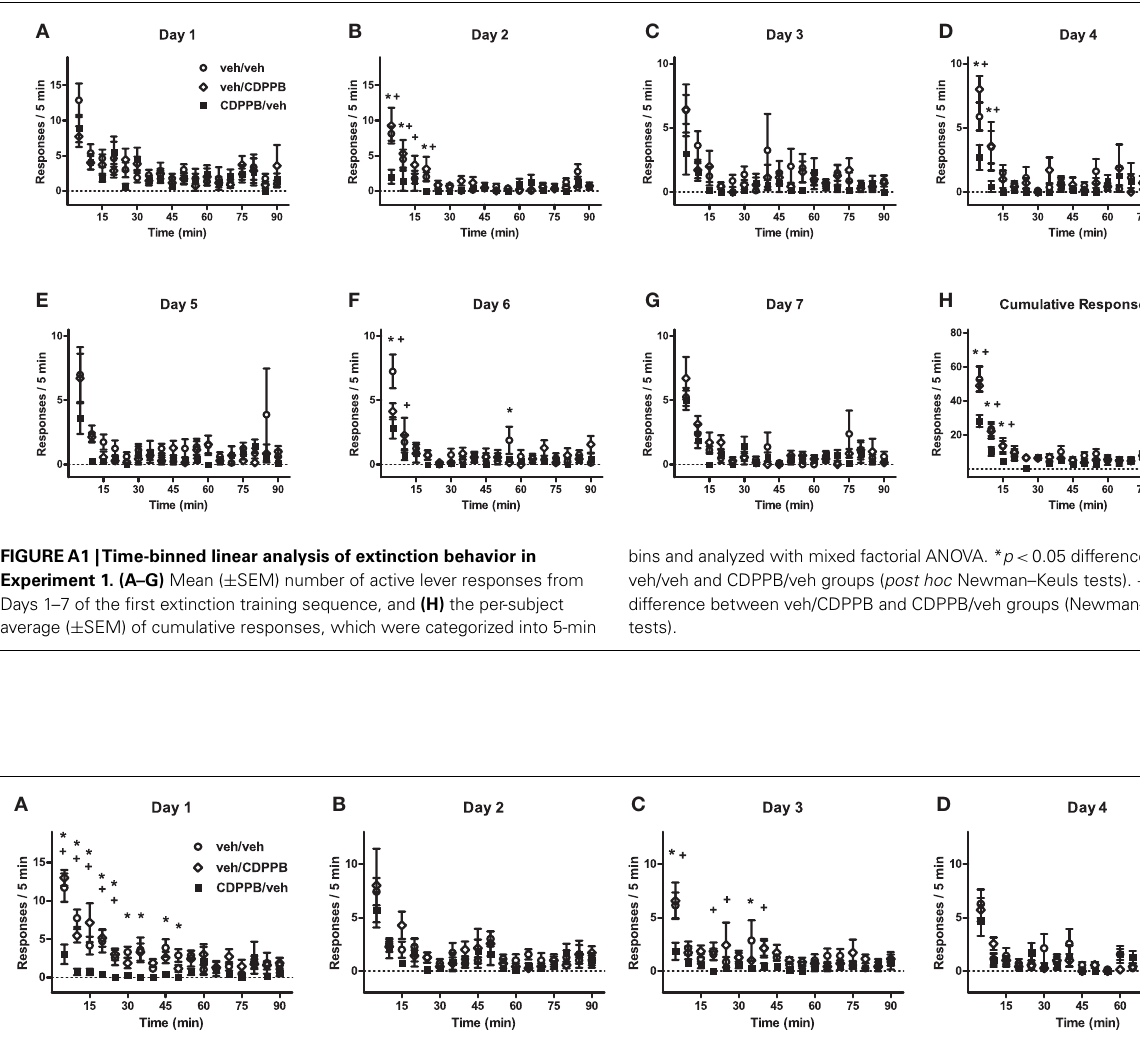
bins and analyzed with mixed factorial ANOVA. * p < 0.05 difference between veh/veh and CDPPB/veh groups ( post hoc Newman–Keuls tests). + p < 0.05 difference between veh/CDPPB and CDPPB/veh groups (Newman–Keuls